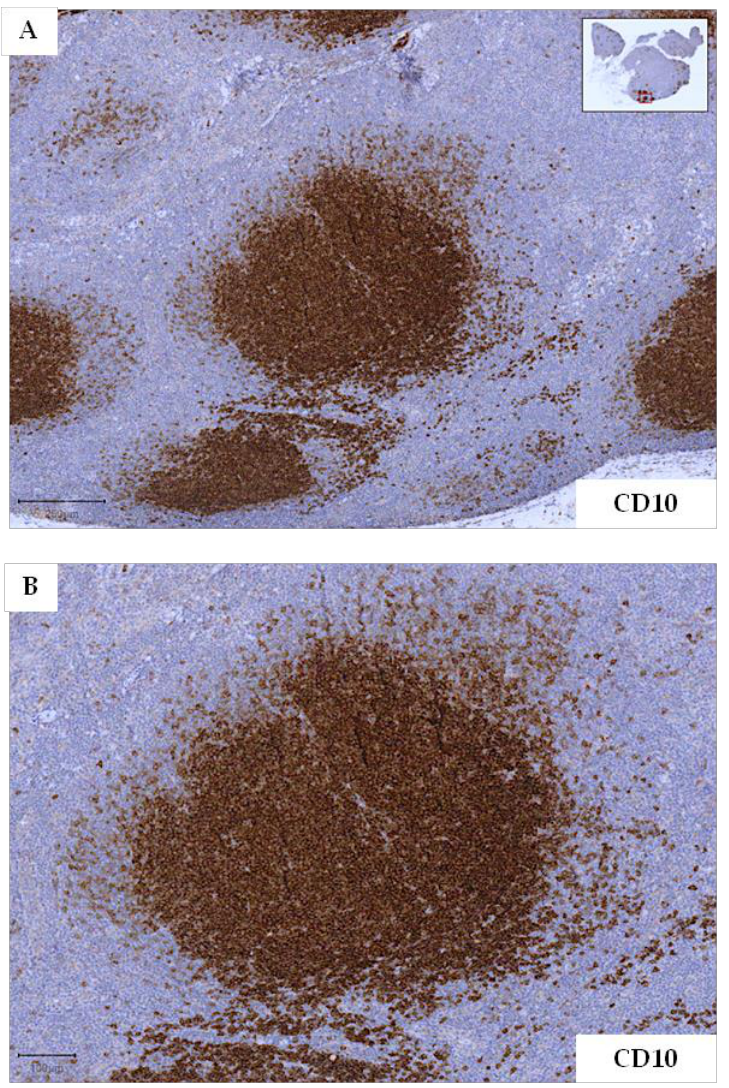
Figure 1. Incipient/early follicular lymphoma. ( A ) At low magnification some lymphoid follicles are occupied by neoplastic cells strongly expressing CD10 staining. ( B ) At higher magnification, neoplastic cells are irregularly present at the border of the neoplastic follicle. (Immunohistochemical staining; 10× ( A ); 20× ( B ) original magnification).